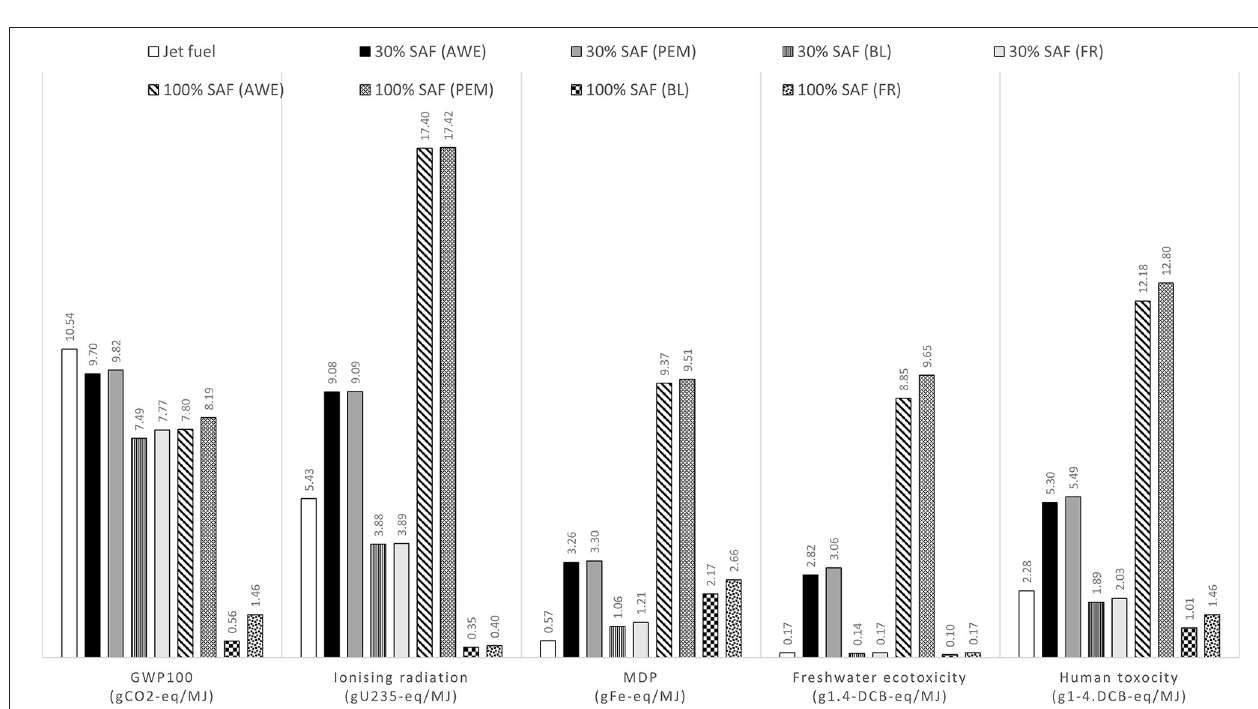
FIGURE 8 | Well-to-pump potential climate impacts (100 years horizon), ionizing radiation, potential mineral depletion, freshwater ecotoxicity and human toxicity per 1MJ of jet fuel, 30% SAF and 100% SAF in 2030.